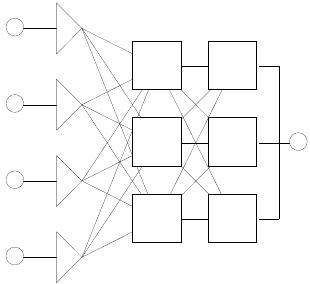
Figure 4. Example of Multilayer perceptron (MLP) network architecture with four layers (first layer with four neurons, second and third layers with three neurons and fourth layer with one